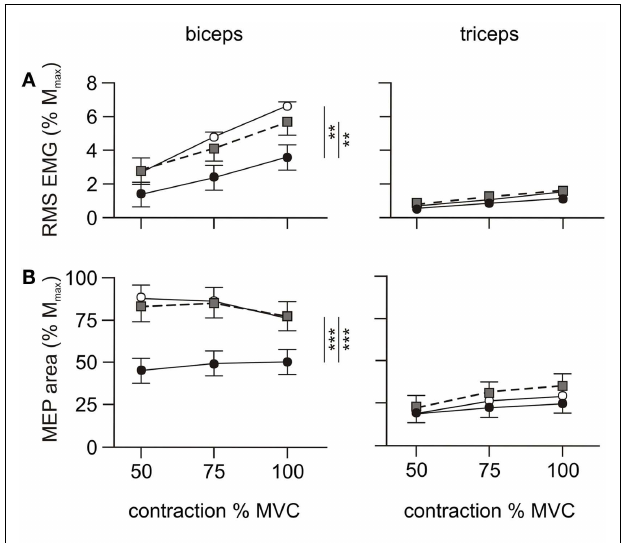
FIGURE 5 | EMG and MEP during the cortical stimulation protocol . RMS EMG and MEP area were measured during voluntary contractions of 50, 75, and 100% MVC. Filled circles and solid line represent the more-affected side, shaded circles and dashed line the less-affected side, and open circles and solid line the healthy subjects.The left hand column shows the results for the biceps, and the right hand column the triceps. Data are presented as mean ± SEM. (A) RMS EMG over 500ms prior to the cortical stimulus and normalized to M max .The triceps error bars and the data for healthy subjects are obscured by other symbols. (B) Area of the MEP evoked by the cortical stimulus normalized to M max .The data for each side of healthy subjects are combined. ** p < 0.01, *** p < 0.001.